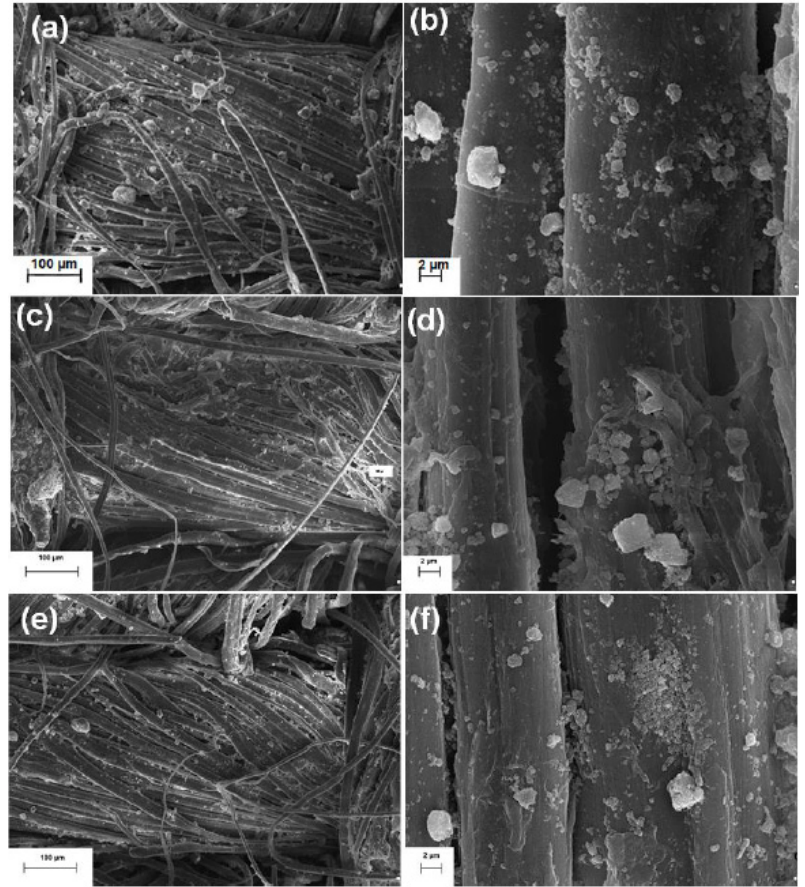
Figure 6. SEM images of: ( a , b ) linen fabric after alkaline treatment and dip-coating with 5% wt. of CuO-SiO 2 , ( c , d ) linen fabric after enzymatic treatment with 2.5 U/g of laccase and dip-coating with 5% wt. of CuO-SiO 2 , ( e , f ) linen fabric after enzymatic treatment with 5.0 U/g of laccase and dip-coating with 5% wt. of CuO-SiO 2 [11] .